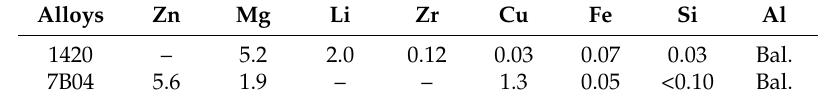
Table 1. Chemical composition of parent metals (wt.%).